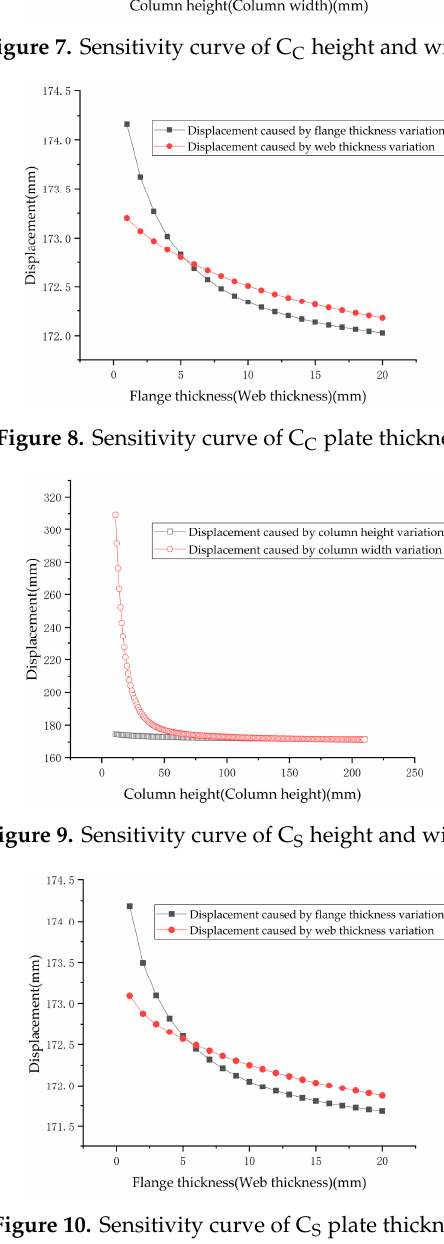
Figure 10. Sensitivity curve of C S plate thickness.